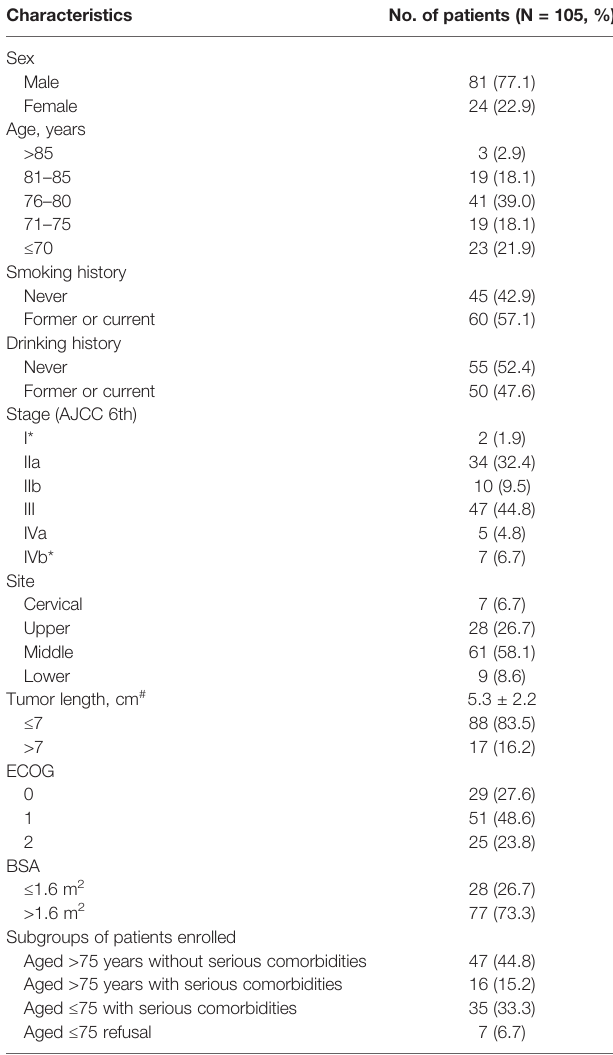
TABLE 1 | Characteristic parameters of enrolled patients.